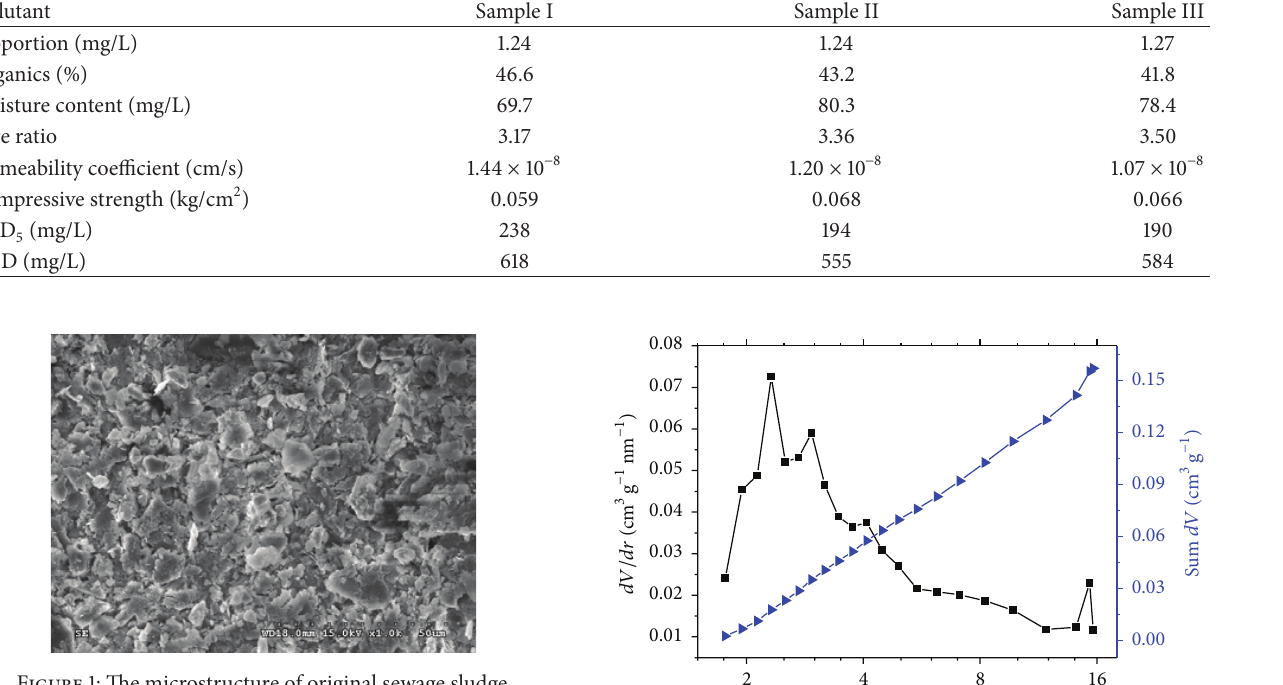
Figure 1: The microstructure of original sewage sludge.